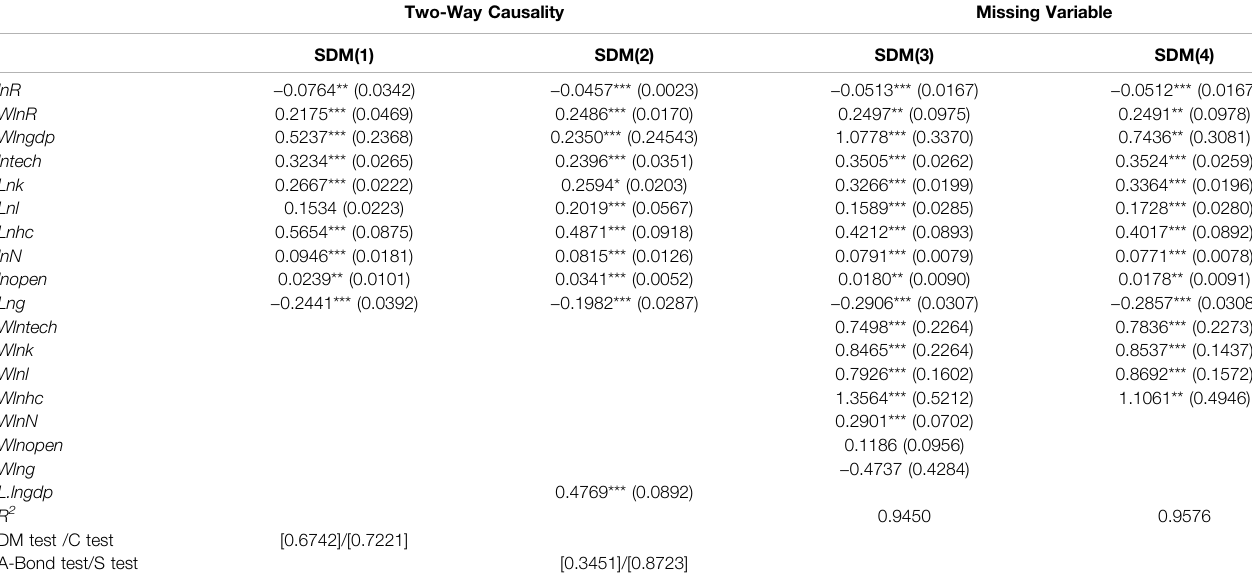
TABLE 5 | Endogeneity test.